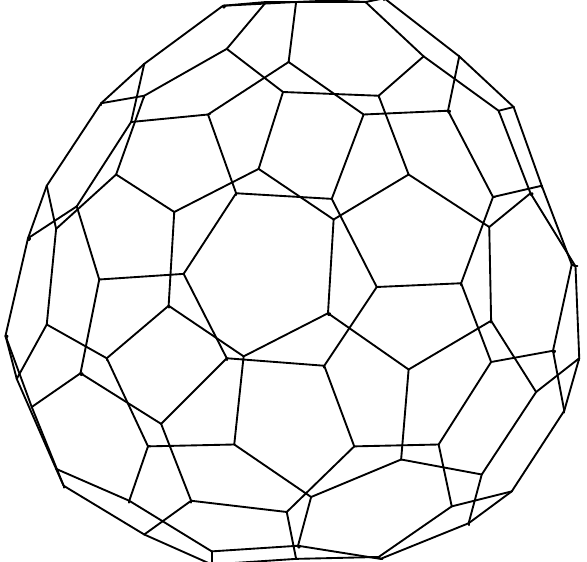
Figure 1. Molecular image of fullerene-82.